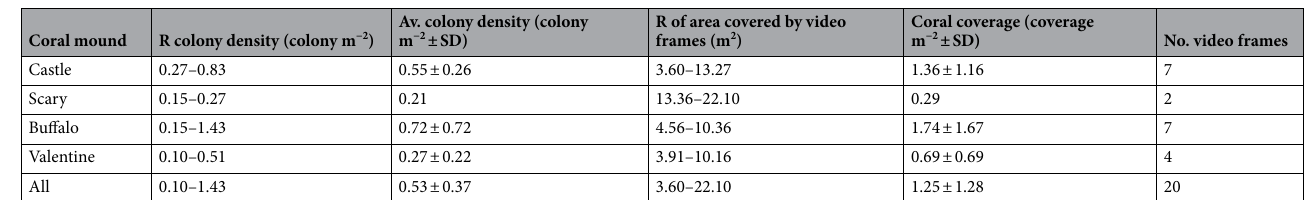
Table 2. Madrepora oculata density and coverage on the Angolan coral mounds (R: range, Av.: average) analysed for 20 down-look video frames.